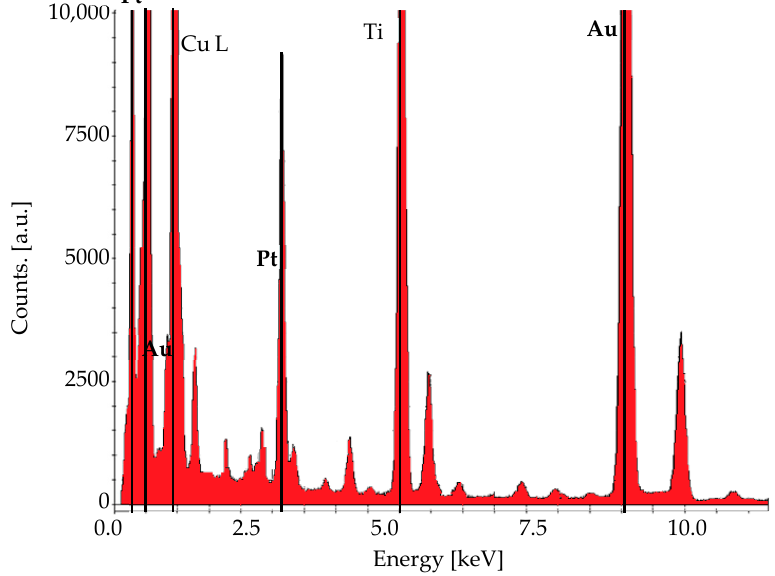
Figure 5. Chemical composition of the synthesized bimetallic sample studied by EDX.